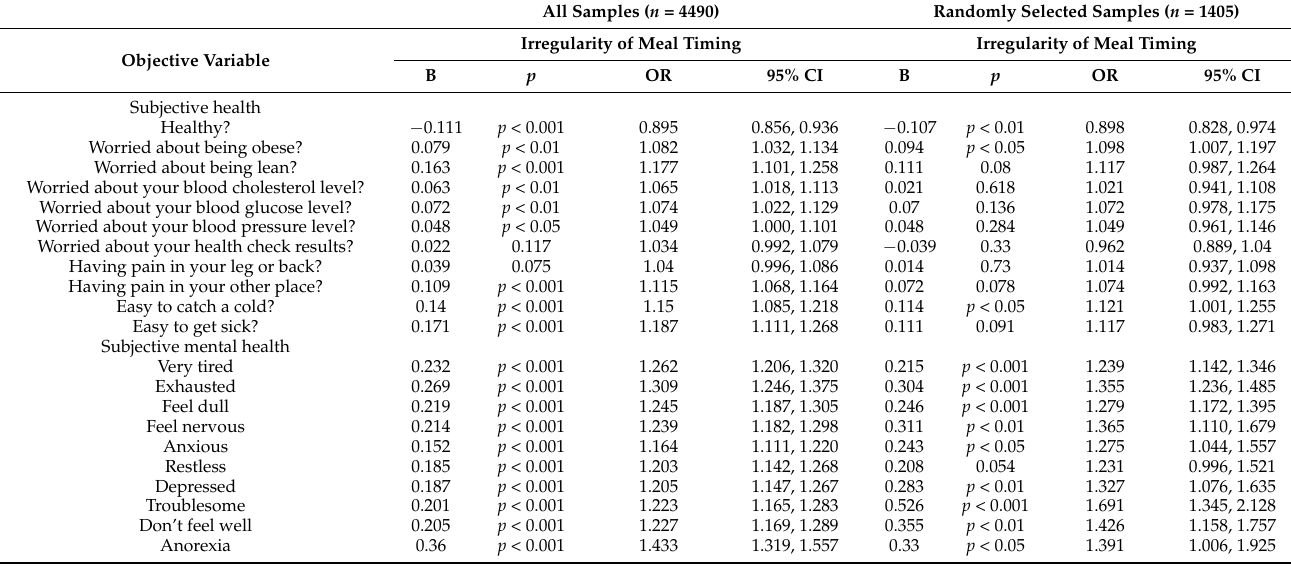
Table 2. Logistic regression analysis for subjective health